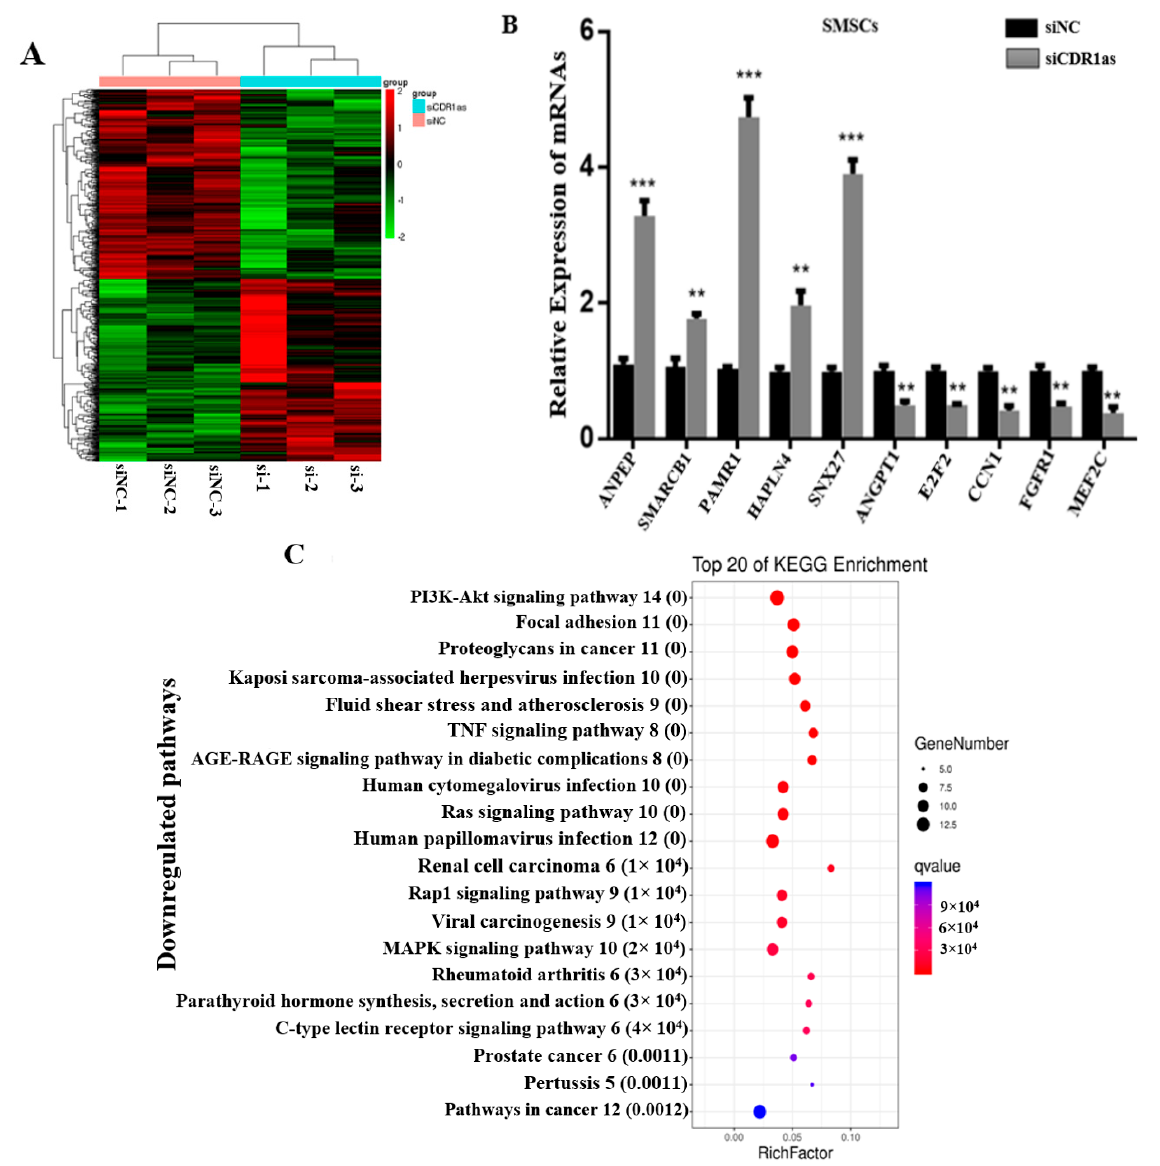
Figure 2. Expression profile of mRNAs in siCDR1as and siNC (SMSCs). ( A ) Sequencing analysis for mRNAs was performed with RNA extracted from siCDR1as ( n = 3) and siNC ( n = 3) SMSCs. Hierarchical cluster analysis of significantly expressed mRNAs: bright green, under-expression; bright red, overexpression. ( B ) Ten differentially expressed representative mRNAs were validated in SMSCs transfected with siCDR1as and siNC by qRT-PCR ( n = 10 per group). GAPDH was used as an internal control. The number of ‘’*” indicates the level of significance (***, p < 0.001, **, p < 0.01). ( C ) KEGG of the downregulated mRNAs with the top 20 enrichments. The bubble color and size correspond to the Q value and gene number enriched in the pathway. The rich factor indicates the ratio of the number of DEGs mapped to a certain pathway to the total number of genes mapped to this